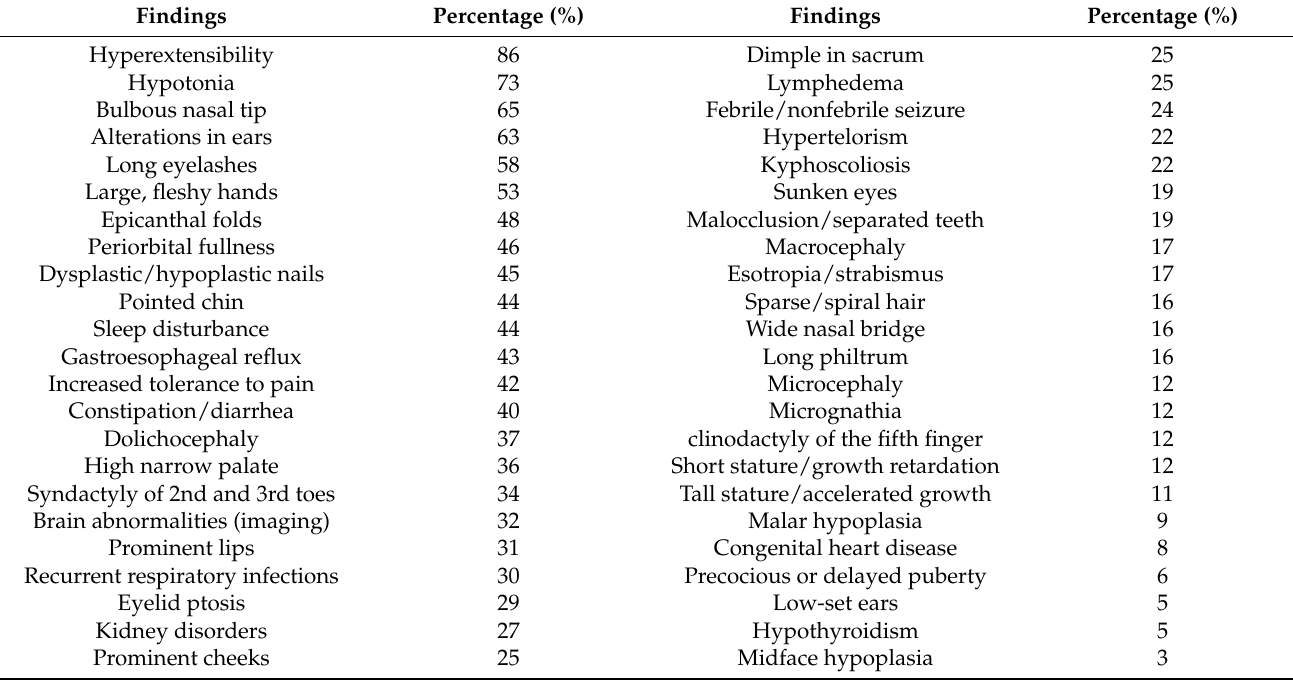
Table 1. Clinical findings associated with PMS